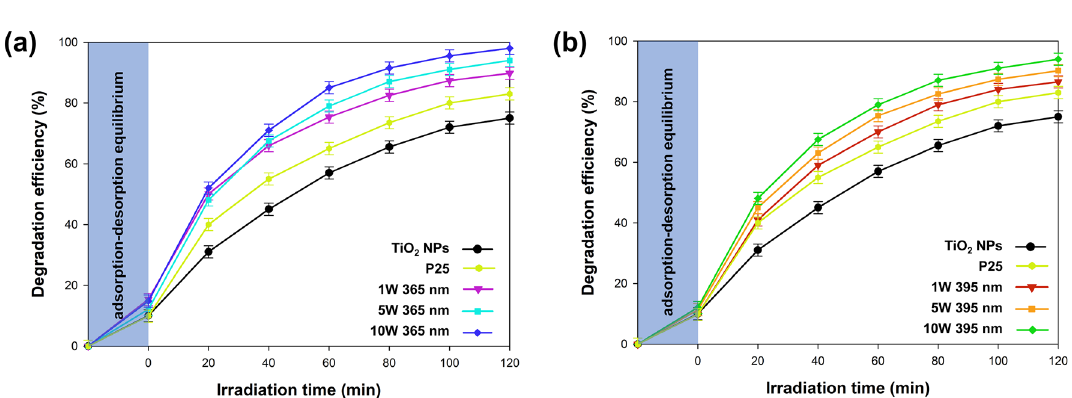
Figure 7. The photo-oxidation results of samples from ( a ) 365 nm and ( b ) 395 nm